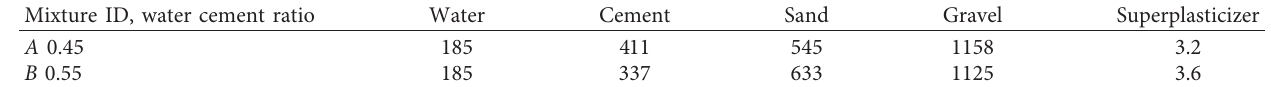
Table 1: Mix proportions of concrete (kg/m 3 ).